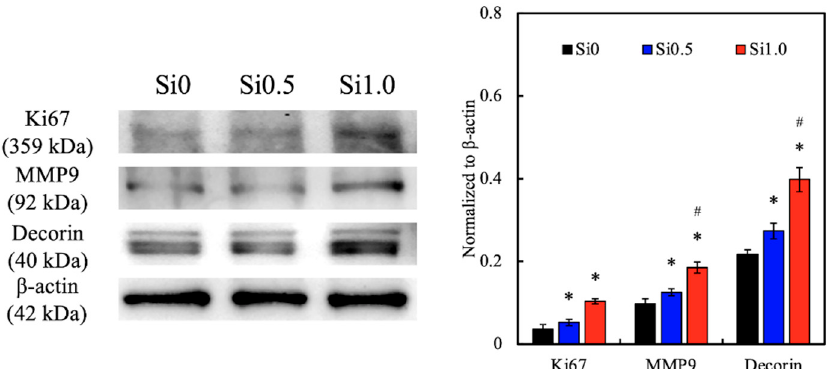
Figure 10. The in vitro effects of the extracellular matrix (ECM) remodeling marker (Ki67, MMP9, and decorin) of hDF cultured on Si-GelMa hydrogels for 14 days. * indicates a significant difference ( p < 0.05) from Si0. # indicates a significant difference ( p < 0.05) from Si0.5.